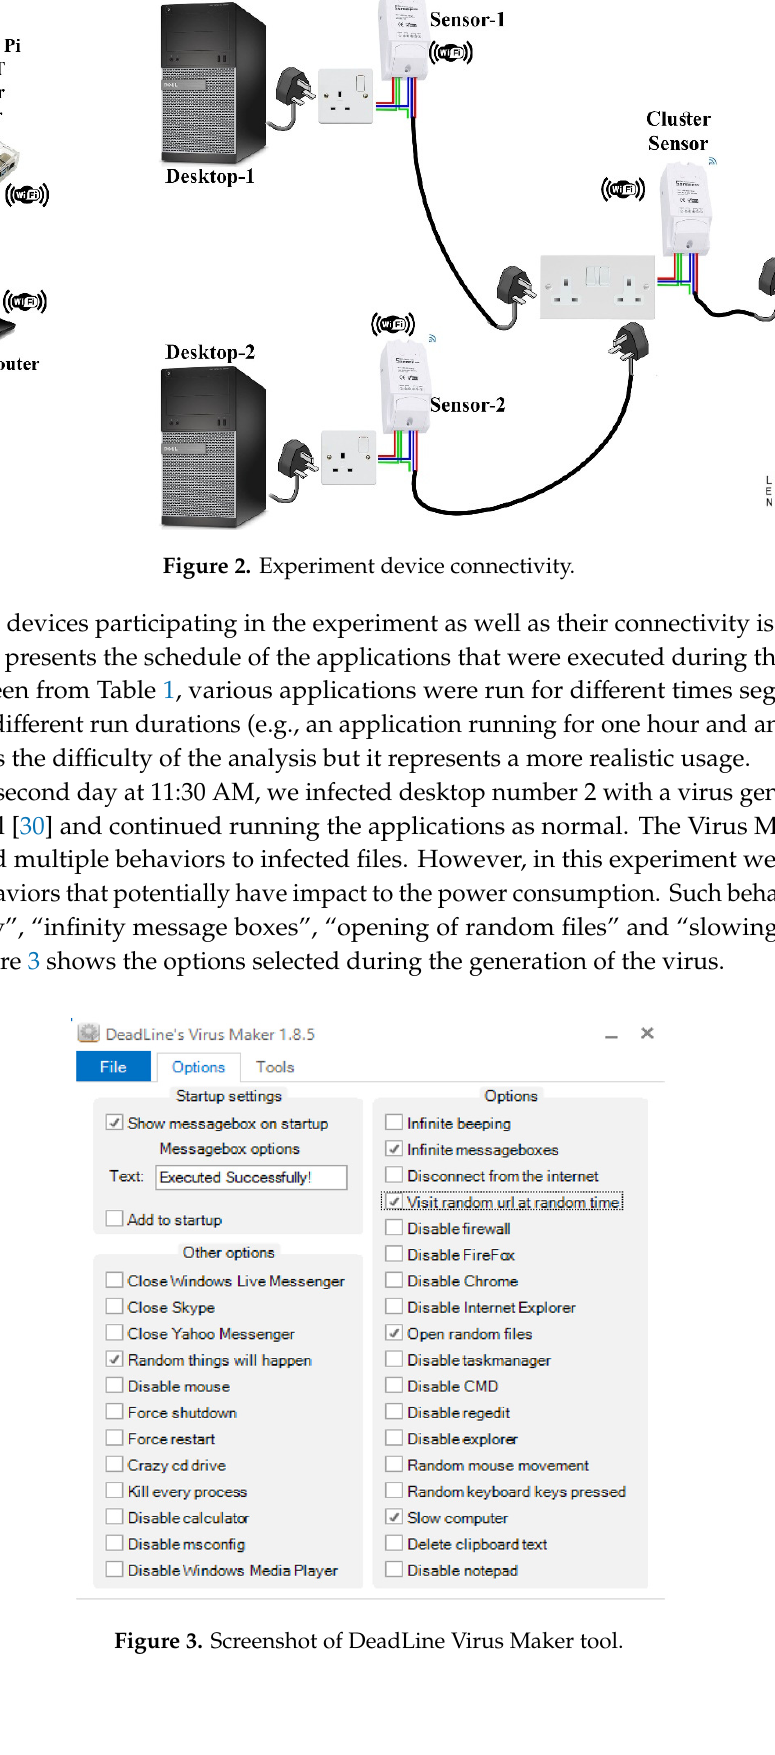
Figure 3. Screenshot of DeadLine Virus Maker tool .